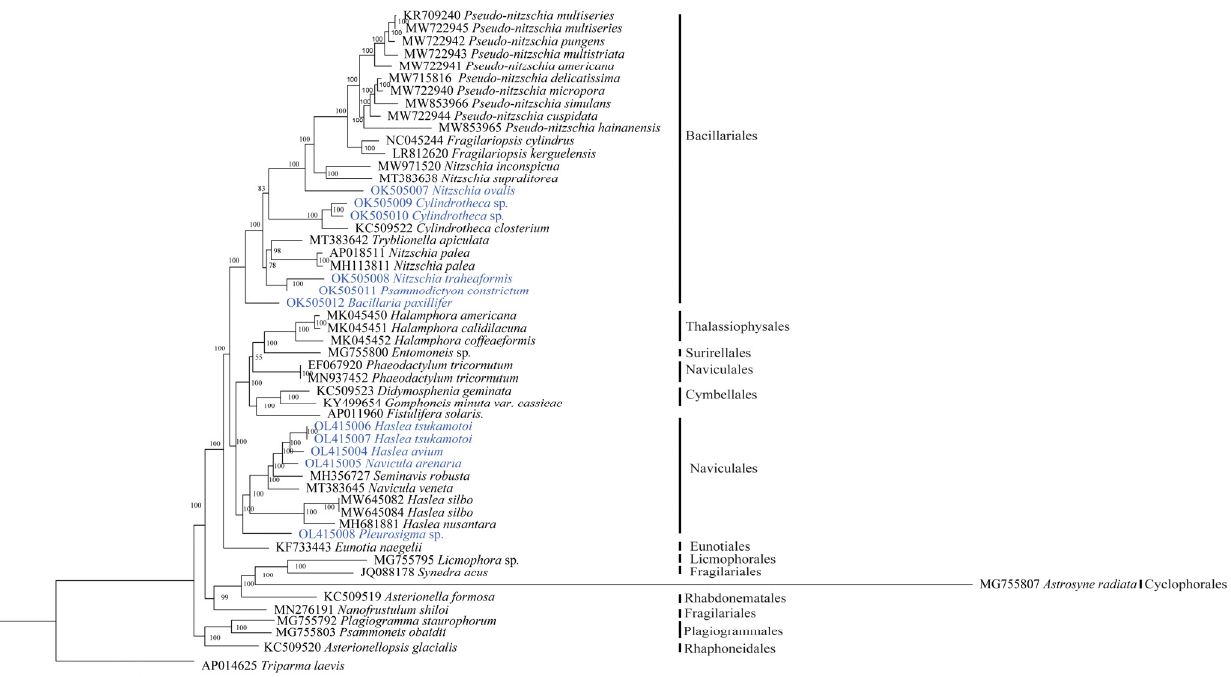
Figure 5. Maximum likelihood (ML) phylogenetic tree of Bacillariophyceae species based on concatenated amino acid sequences encoded by 108 shared protein-coding genes. Numbers on the left- and right-side at the branches represent bootstrap values. Branch lengths were proportional to the amount of sequence change, which are indicated by the scale bar below the trees.